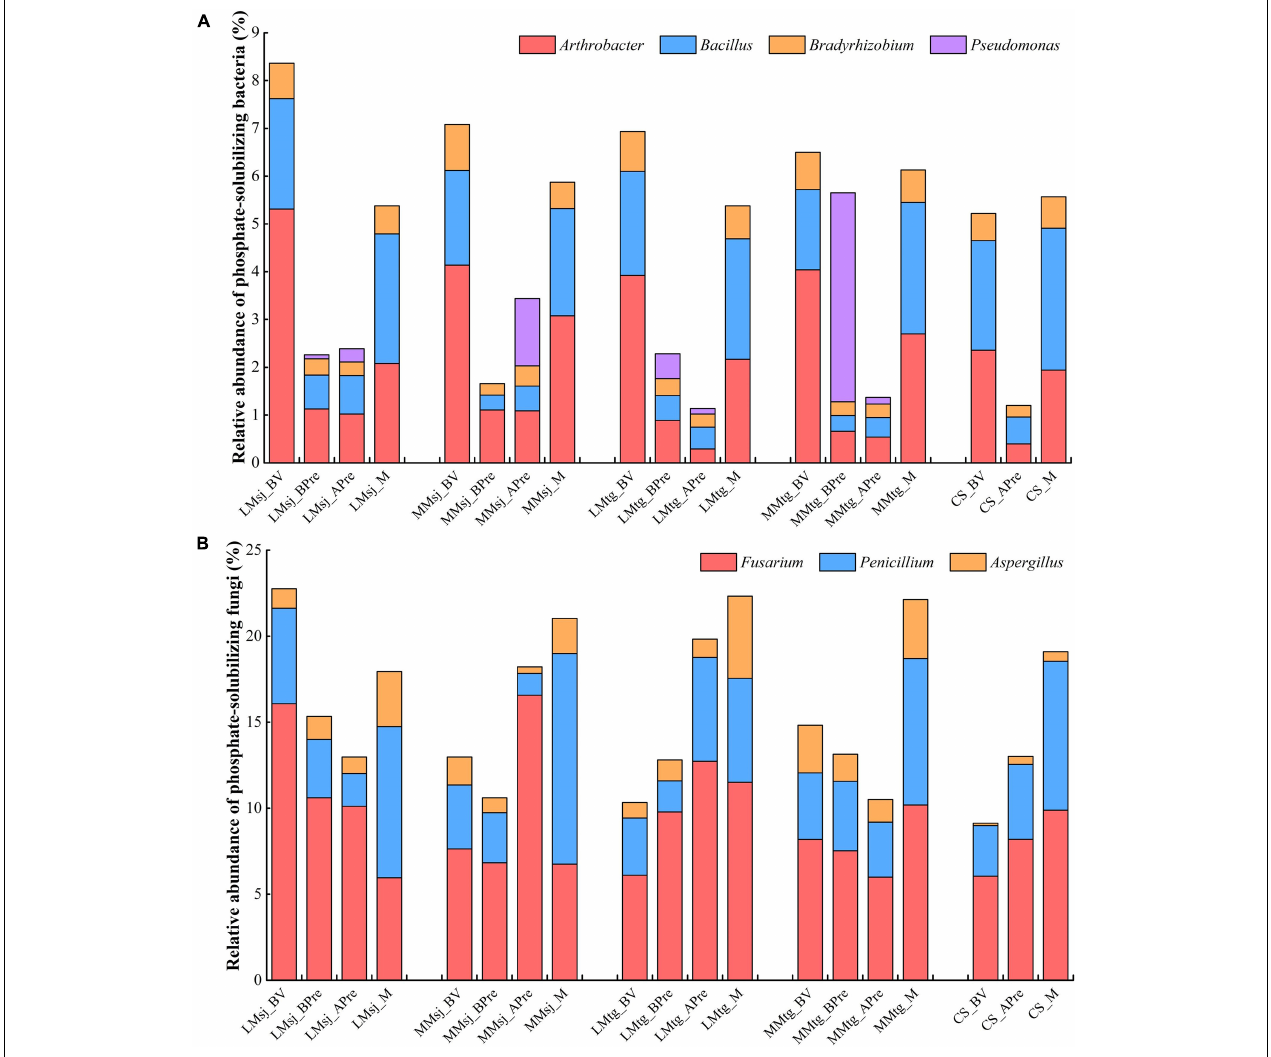
FIGURE 2 | The relative abundance of (A) phosphate-solubilizing bacteria. (B) Phosphate-solubilizing fungi. LMsj, light drought-moderate flood in the seeding-jointing stage (SJS); LMtg, light drought-moderate flood in the tasseling-grain filling stage (TGS); MMsj, moderate drought-moderate flood in the SJS; MMtg, moderate drought-moderate flood in the TGS; CS, control system operated under natural climatic conditions; BV, baseline value; BPre, before precipitation (after drought); APre, after precipitation (after drought-flood abrupt alternation/natural rainfall); M, at the mature stage.